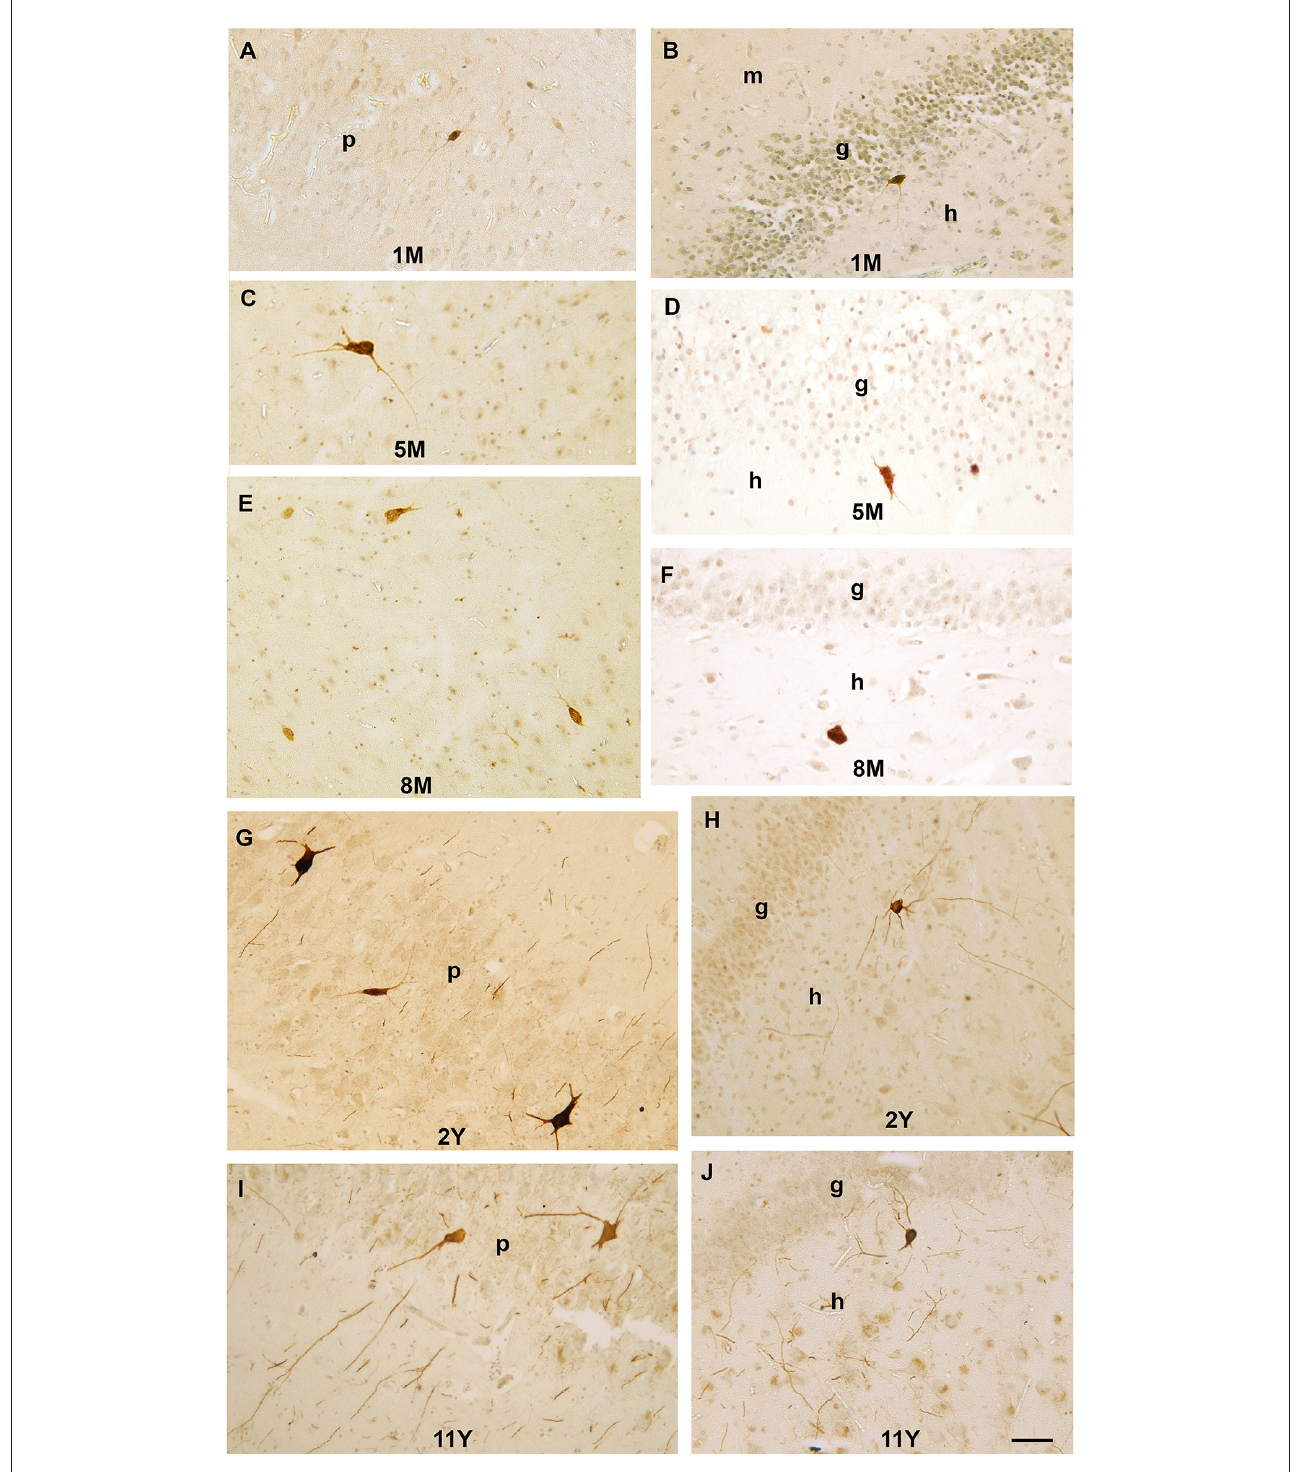
FIGURE3 Photomicrographs showing PV-immunoreactive neurons during postnatal development of the human hippocampal formation. (A) A PV-immunoreactive cell with immature morphology and thin dendrites in the pyramidal layer of CA3 region in a 1-month-old infant. (B) A small PV-immunoreactive cell with immature morphology in the subgranular layer of the dentate gyrus. (C) Large PV-immunoreactive neuron with several dendrites next to the CA1 pyramidal layer in a 5-month-old infant. (D) A PV-immunoreactive cell in the subgranular layer of the dentate gyrus at the age of 5 months. (E) PV-immunoreactive neurons next to the CA3 pyramidal layer in an 8-month-old infant. (F) A PV-immunoreactive cell in the dentate hilus in an 8-month-old infant. (G) Large PV-immunoreactive neurons and several sections of PV-positive dendrites in the CA1 pyramidal layer of a 2-year-old child. (H) Large PV-immunoreactive neurons with several long dendrites in the hilus of the dentate gyrus in a 2-year-old child. (I) Large PV-immunoreactive neurons and several sections of PV-positivedendritesintheCA1pyramidallayerofan8-year-oldchild. (J) PV-immunoreactiveneuronandsectionsofPV-positivedendritesinsubgranular position of an 8-year-old child. Scale bar = 50 µ m. Abbreviations: g, granule cell layer; m, molecular layer; h, hilus of the dentate gyrus; p, pyramidal layer of CA1, CA3, regions of Ammon’s